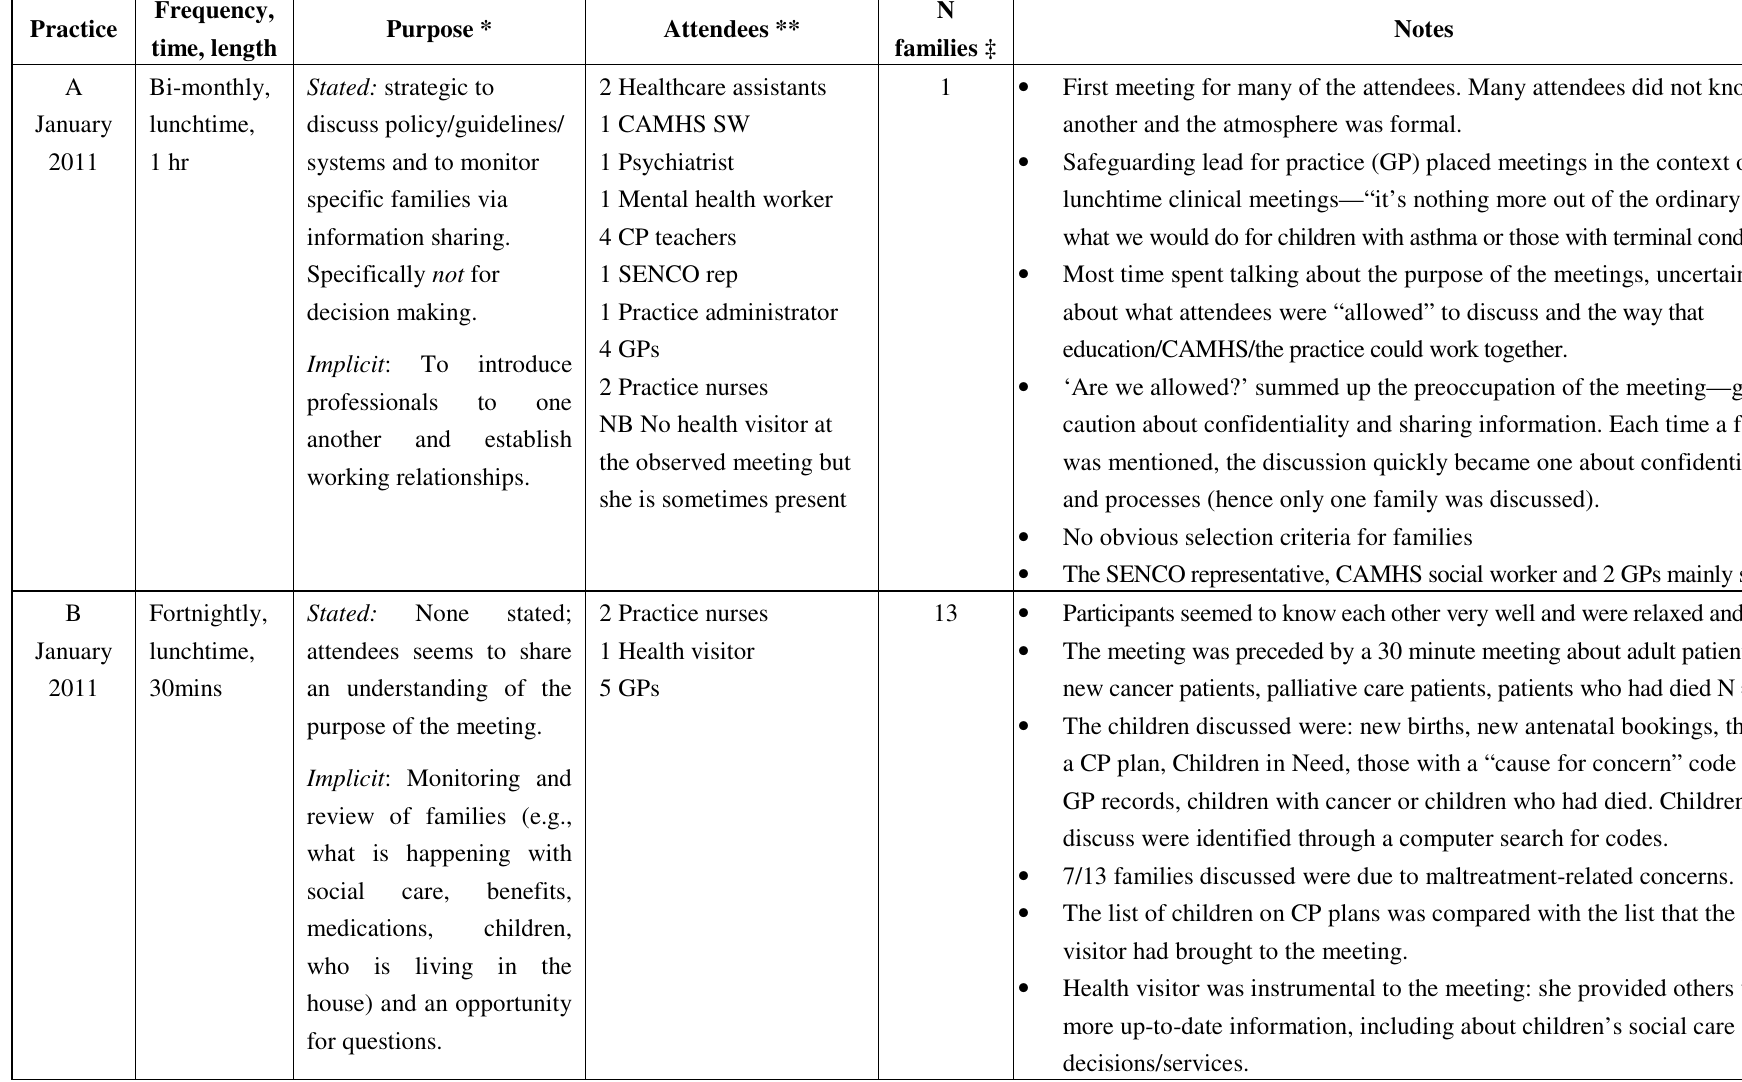
Table 1. Description of vulnerable families meetings (from